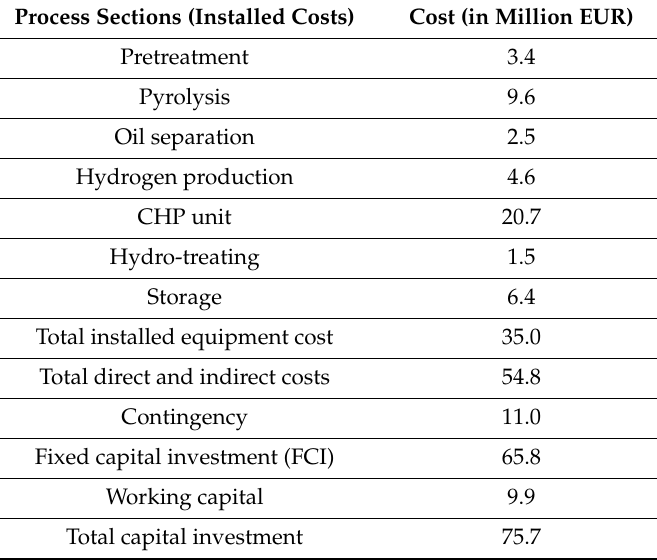
Table 1. Capital costs for pyrolysis plant using Cs / amorphous silica alumina (ASA) as a catalyst for pyrolysis.